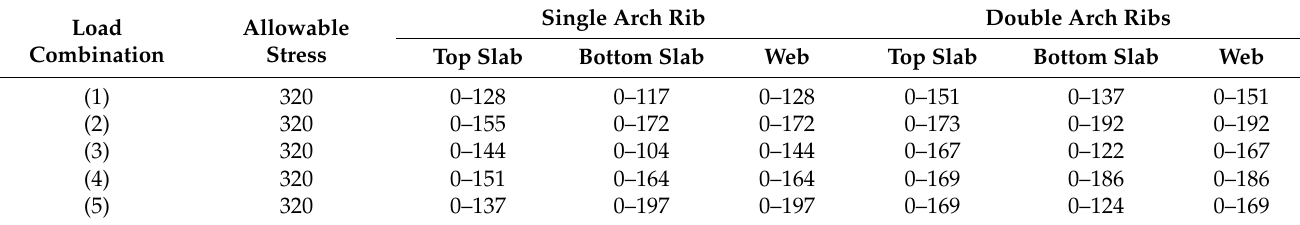
Table 10. Von Mises stress distribution of arch ribs under the design load combination (unit: